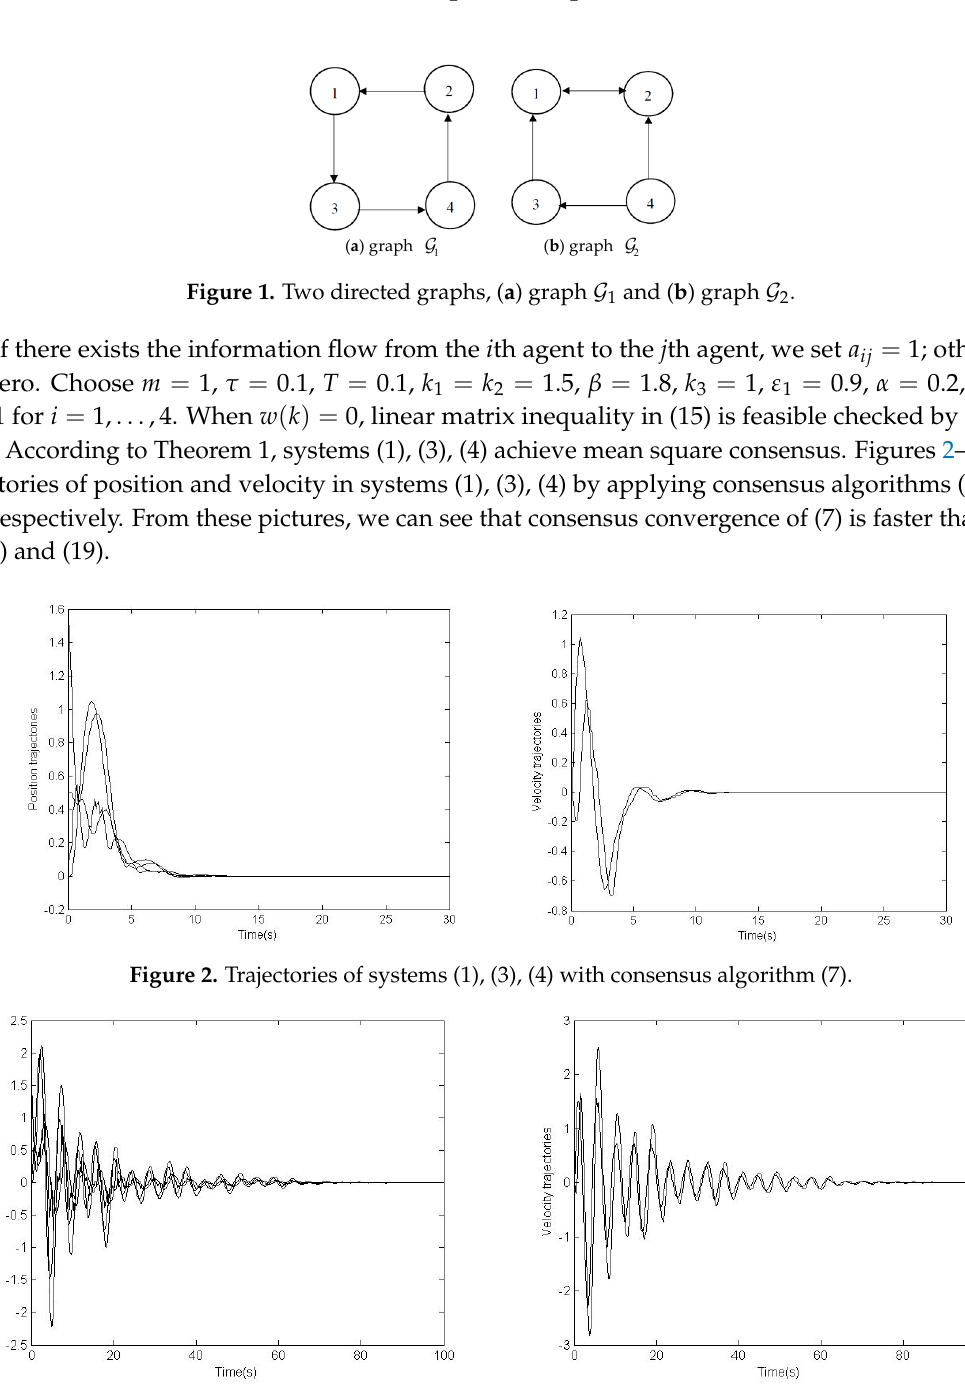
Figure 3. Trajectories of systems (1), (3), (4) with consensus algorithm (18).